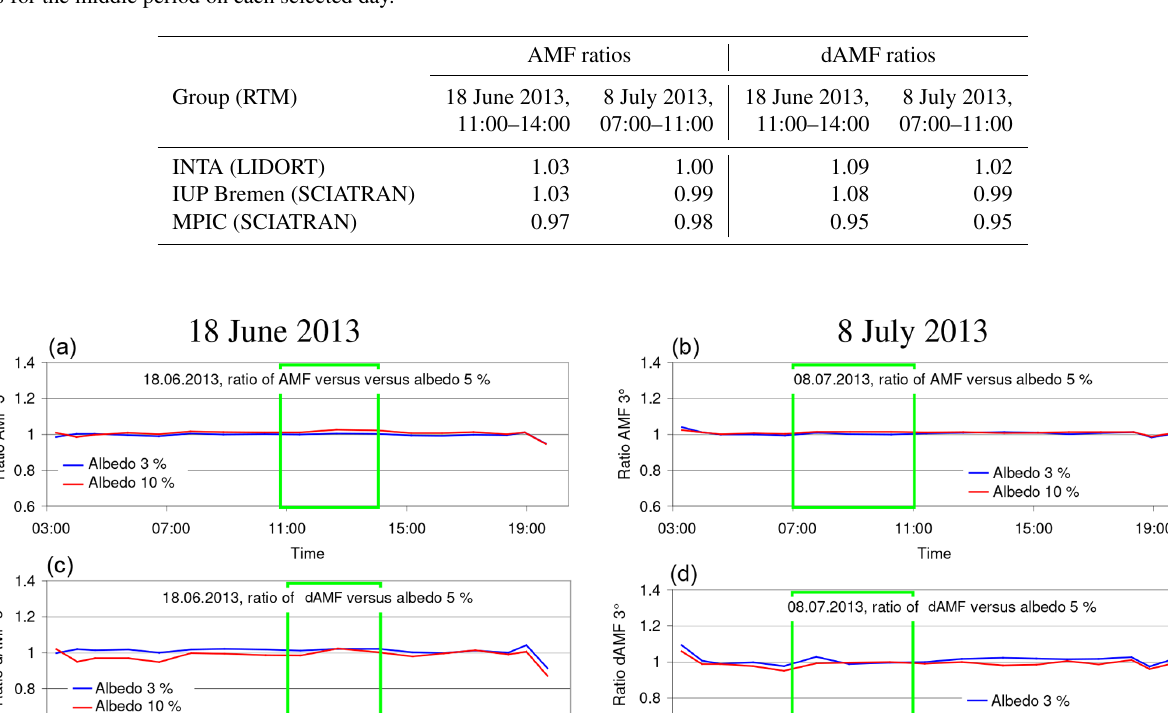
Table A9. Average ratios of O 4 (d)AMFs simulated by INTA and IUP Bremen and MPIC (SCIATRAN) for phase functions derived from the sun photometer measurements vs. those simulated by MPIC using the Henyey–Greenstein phase function for an asymmetry parameter of 0.68 for the middle period on each selected day.